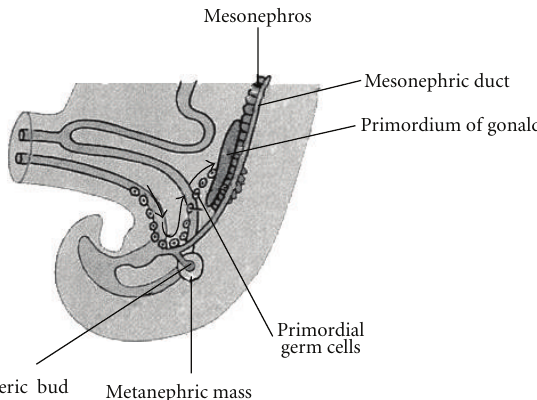
Figure 6: Migrational theory of primordial germ cells [4]. Repro- duced by permission of Elsevier